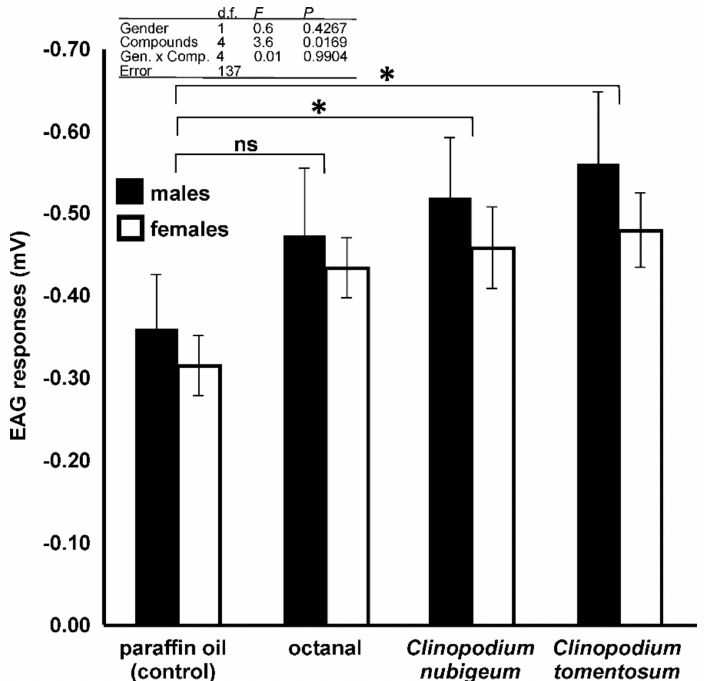
Figure 10. EAG responses (mV) of male and female antennae of Sitophilus zeamais to compounds dissolved in para ffi n oil at 10% (v / v) concentration. Bars indicate the mean ± standard error. Table inset shows the statistical parameters of two-way ANOVA. The response of the two gender to each compound is compared to those of the control (para ffi n oil) (*, p < 0.05; ns, not significant; ANOVA, Dunnett post hoc